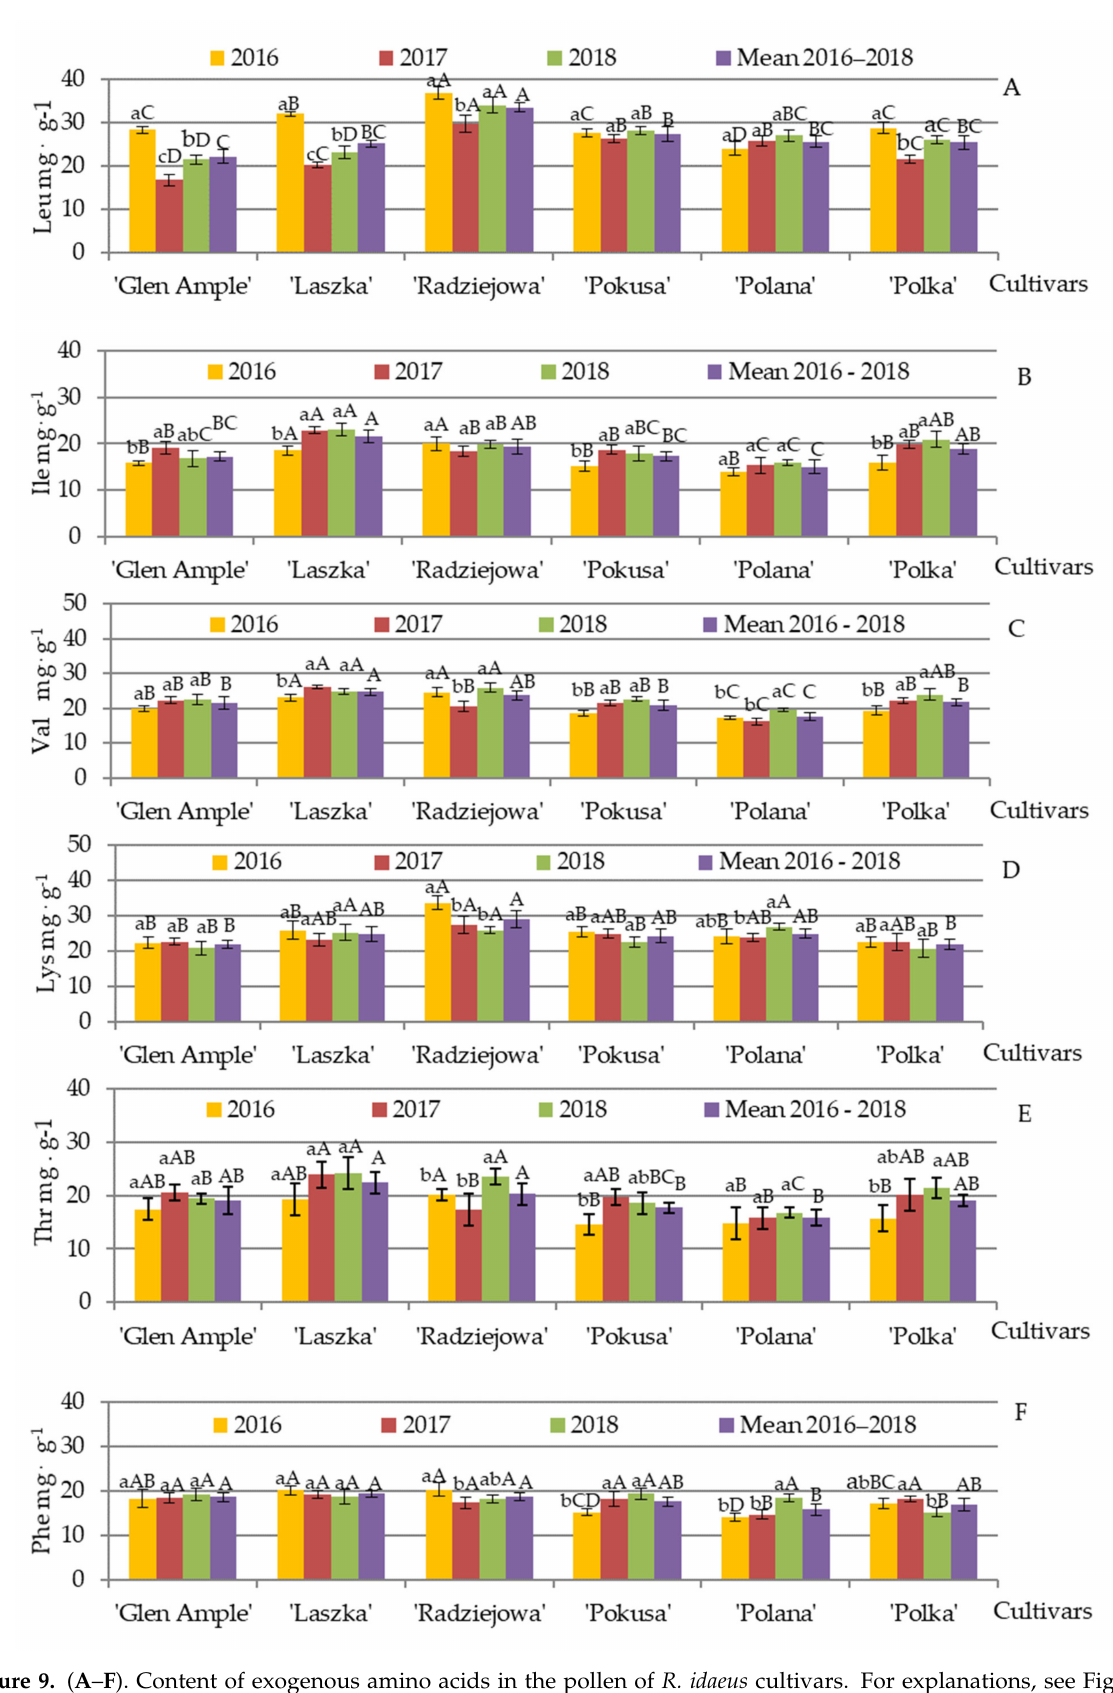
Figure 9. ( A – F ). Content of exogenous amino acids in the pollen of R. idaeus cultivars. For explanations, see Figure 8 (number of repetitions in each year n =